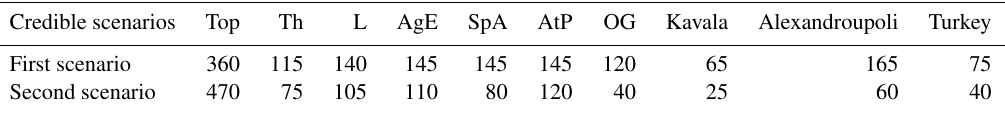
Table 2. Table of maximum elevation (cm) of the water level for 10 places where the tsunami was amplified. Top means above the marine landslide, AgE is Agios Efstratios, AtP is Athos peninsula, L is Lemnos (Gulf of Pournia), OG is Gulf of Orfani, SpA is Sporades archipelago and Th is